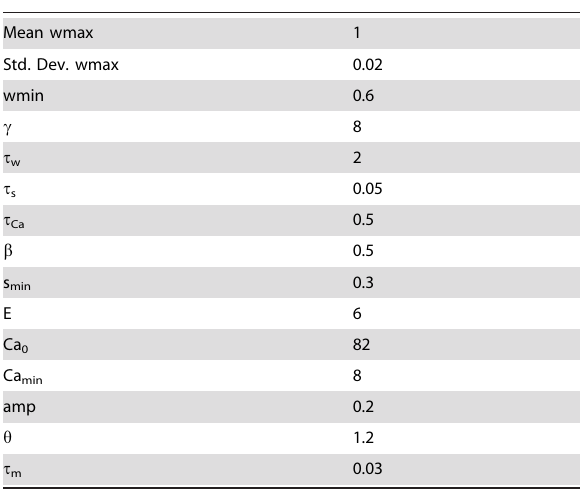
Table 1. Network parameters. Table 2. Mean connectivity values for the 2 population